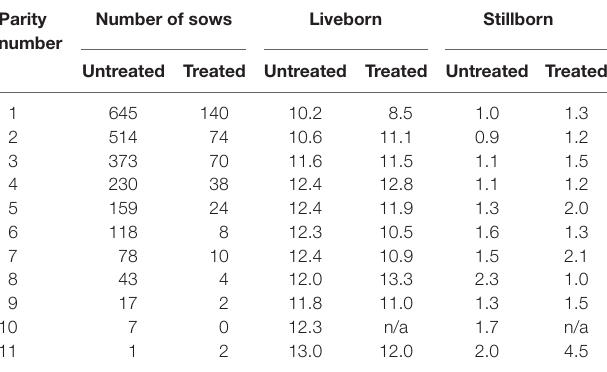
Table 1 | The number of liveborn and stillborn piglets (mean) by parity for sows treated healthy and thus untreated. Parity number of sows liveborn number